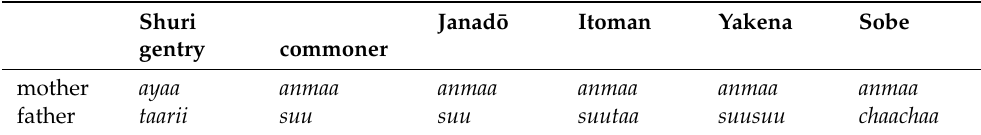
Table 3. Variation in kinship terms in different Okinawan varieties.